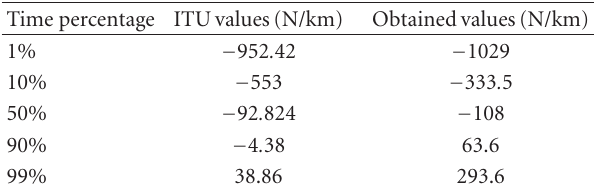
Figure 2: Cumulative distribution of the refractivity gradient at 65m. Table 1: Values of dN not exceeded for di ff erent time percentages compared with ITU